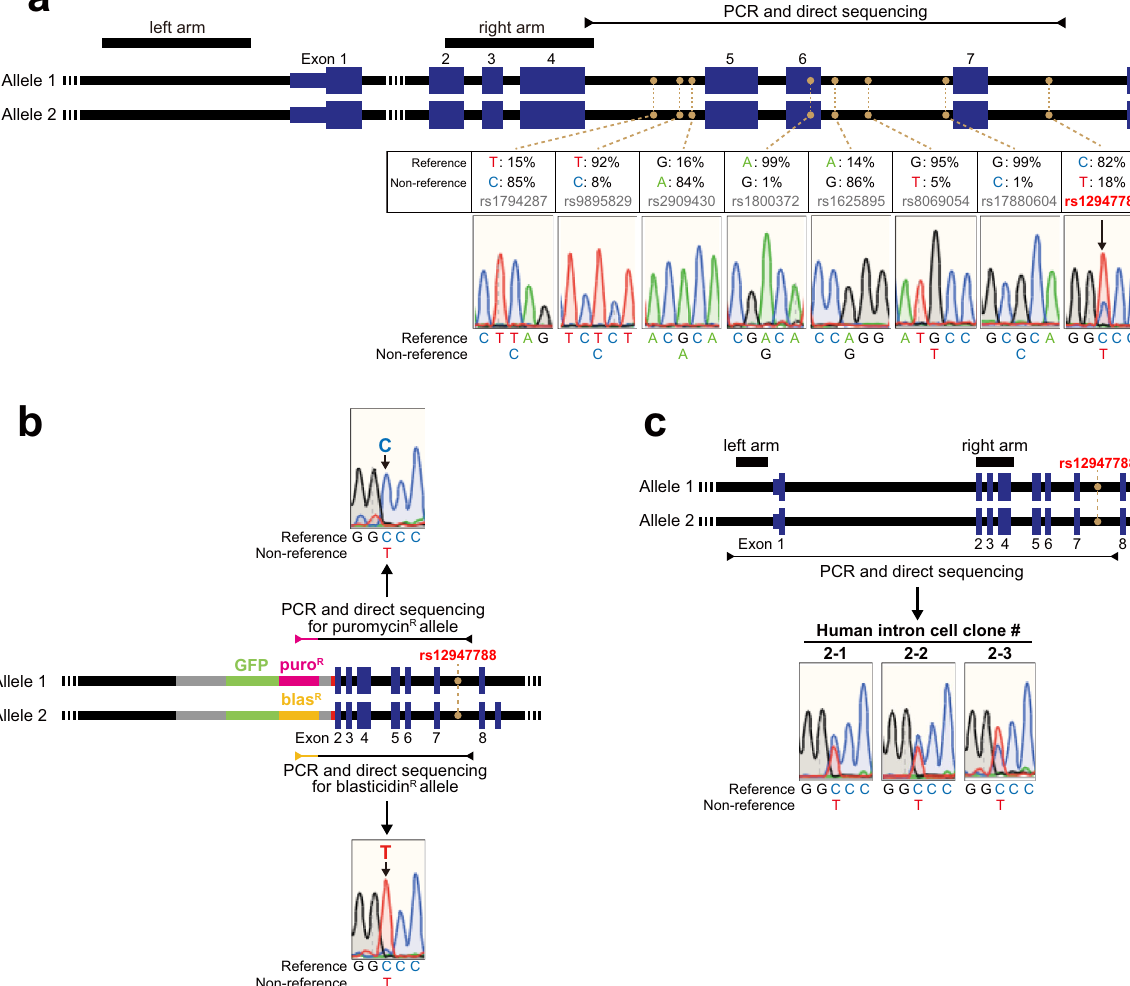
Fig. 4 Validation of biallelic replacement of the fi rst intron of TP53 in the fi rst and second step of UKiS. a Graphical representation of the human TP53 locus, indicating the positions and allele frequencies of eight common SNPs ( fi lled orange circles; from dbSNP151 42 ). Among them, direct sequencing of PCR amplicons from genomic DNA of the parental HCT116 cells demonstrated that the SNP site rs12947788 is heterozygous in HCT116 (black arrow). Black boxes represent homology arms used in our UKiS mutagenesis to TP53 , and the horizontal line fl anked by two arrowheads represents the target region for PCR and subsequent sequencing. b Genotyping of clone #1 – 10, which was used to create all the TP53 mutant clones in this study. Allele-speci fi c PCR was performed by using primers for puromycin or blasticidin marker sequences. The puromycin and blasticidin alleles had C and T at rs12947788, respectively. Horizontal lines fl anked by two arrowheads represent the target region for the PCR of each allele. The heterozygous SNP site, rs12947788, is indicated within the 7th intron with fi lled orange circles. c For human wild-type intron clones #2 – 1, #2 – 2, and #2 – 3, graphical representation of the human TP53 locus is shown on the top: black boxes represent the positions of homology arms used in our UKiS mutagenesis to TP53 , the horizontal line fl anked by two arrowheads represents the target region for PCR, and the fi lled orange circles denote the heterozygous SNP site rs12947788. Direct sequencing of the PCR genotyping amplicons indicated double peaks only at rs12947788 on the resultant sequencing chromatograms for these three